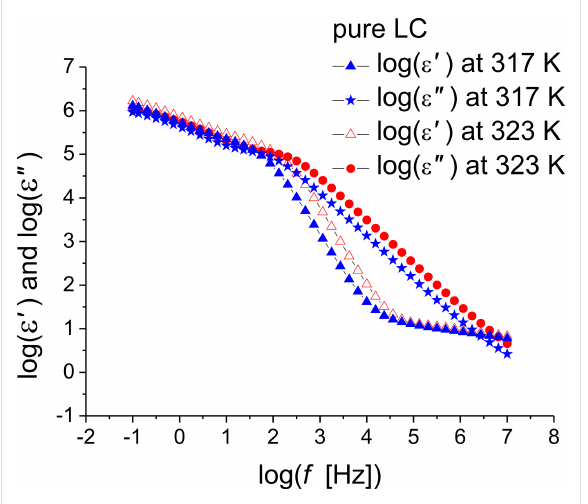
Figure 8: Permittivity and dielectric loss as functions of the frequency (logarithmic scale) for the pure ILC at two constant temperatures, 317 and 323